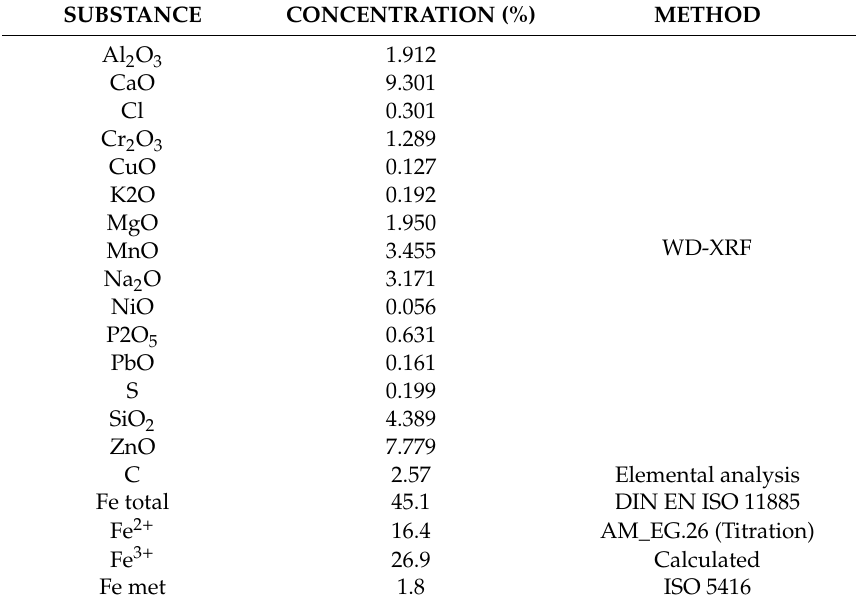
Table 7. Chemical analysis of SIDENOR combustion chamber dust samples.